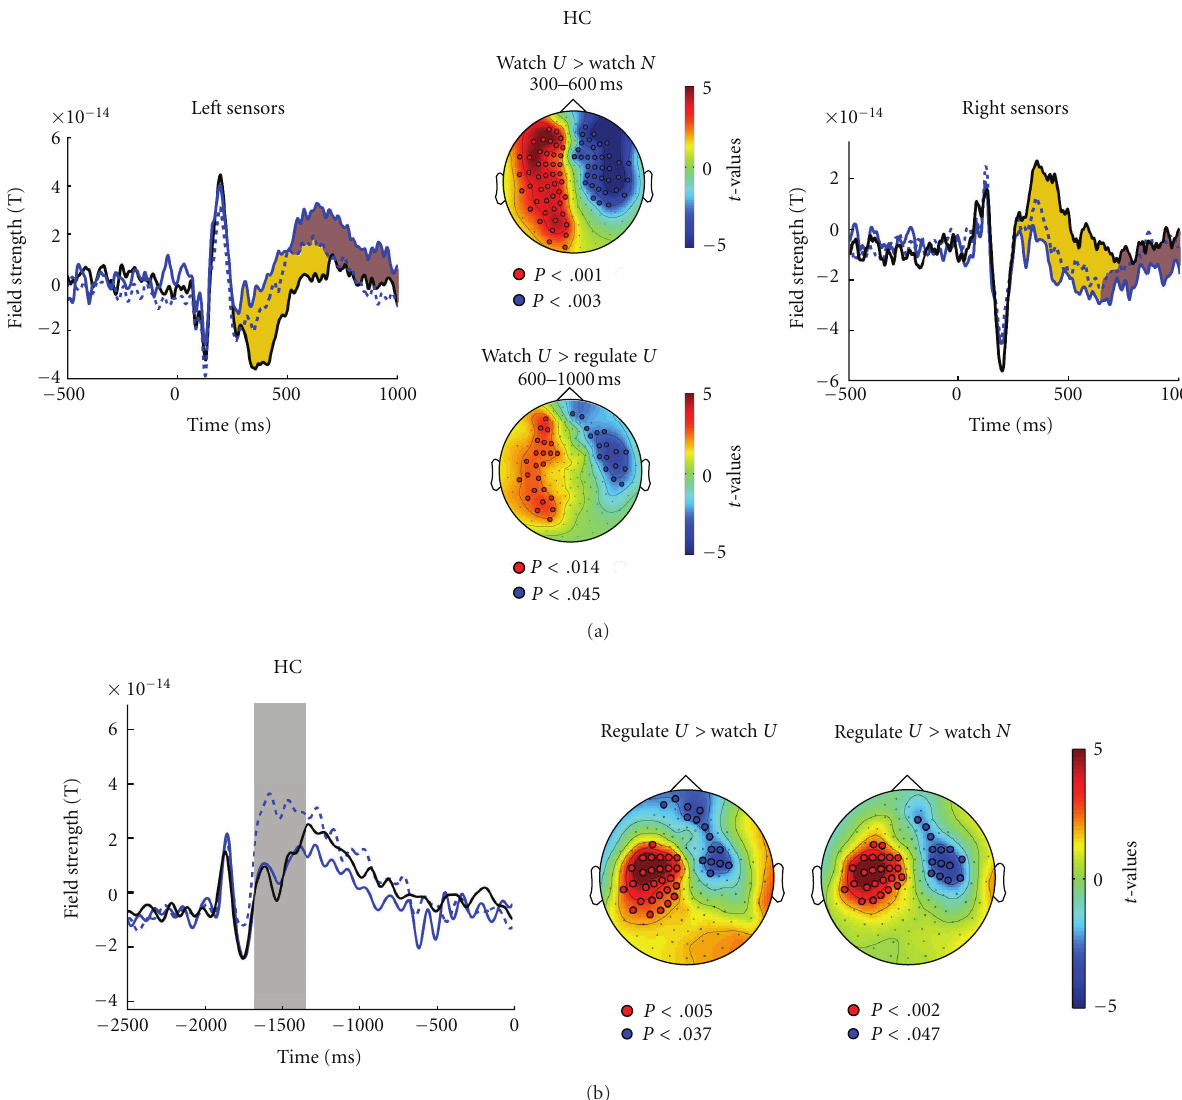
Figure 1: (a) Time course of field strength around picture onset at 0ms for watch-neutral (solid black lines), watch-unpleasant (solid blue lines), and down-regulate-unpleasant conditions (dotted blue lines) for healthy control participants (HC). The left panel illustrates left-hemisphere sensors, the right panel right-hemisphere sensors. In- and outgoing magnetic fields explain the opposite direction of the e ff ect. Periods during which conditions di ff er significantly are marked in yellow for watch-unpleasant versus watch-neutral (Emotion e ff ect) and in brown for watch-unpleasant versus down-regulate-unpleasant (Instruction e ff ect). The center panel presents t -maps projected onto a schematic top view (left = left) testing watch-unpleasant versus watch-neutral (Emotion e ff ect) 300–600 ms after picture onset (top) and comparing watch-unpleasant versus down-regulate-unpleasant (Instruction e ff ect) 600–1000 ms after picture onset (bottom). Sensors defining the significant cluster are marked by open circles). (b) Time course of field strength preceding cross cue onset ( − 2000 ms) to picture onset (0) ms for watch-neutral (solid black line), watch-unpleasant (solid blue line), and down-regulate-unpleasant (dotted blue line) conditions for HC group. The gray bar marks the epoch of significant di ff erences between conditions. t -maps projected onto a schematic top view are plotted below, testing down-regulate-unpleasant versus watch-unpleasant conditions and testing down-regulate-unpleasant versus watch-neutral. Red and blue colors represent sensor clusters that show significant ( P < . 01) di ff erences in field strength between conditions. Sensors defining the significant clusters are marked by open circles. The di ff erent direction of e ff ects explains positive and negative t -values referring to the left (positive t -values, red) and right (negative t -values, blue) hemisphere